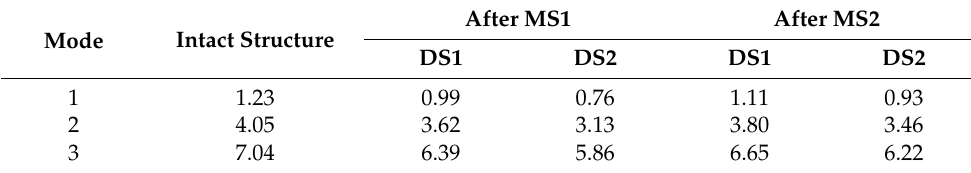
Table 5. Natural frequencies of the intact RC frame and MD-RC frame